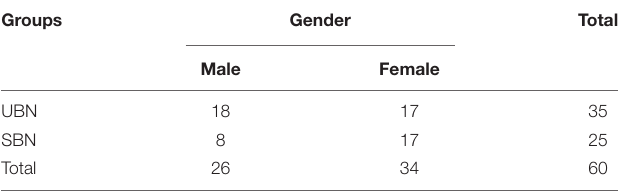
TABLE 1 | Composition of the sample by SES and gender. Groups